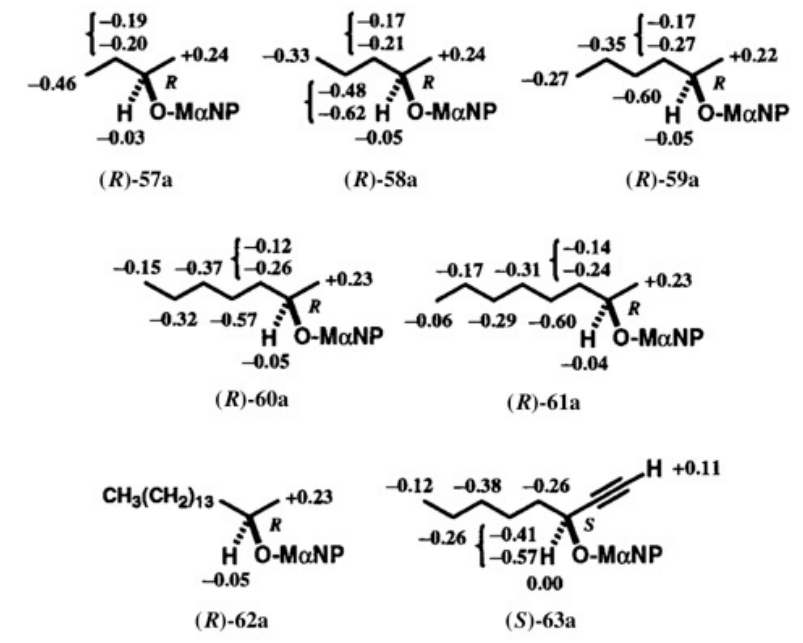
Figure 42. 1 H-NMR ∆ δ values in ppm and ACs of the first-eluted M α NP esters. Reprinted with permission from [58].